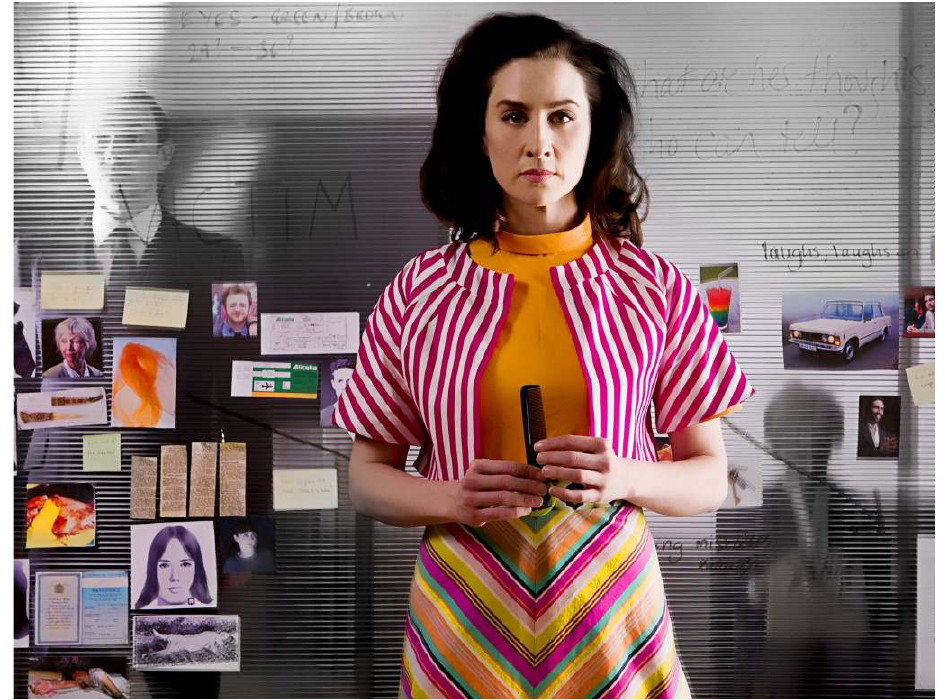
This graphic interlude features a selection of pictures and videos illustrating the topic of this issue: “The Torn